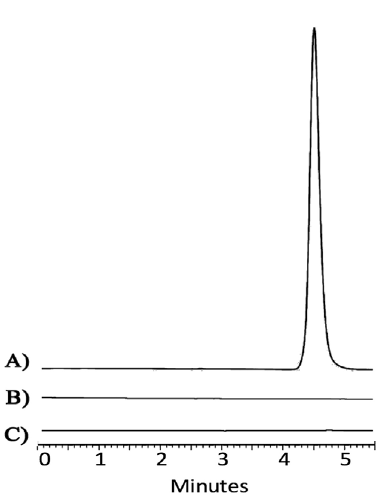
FIGURE 2 - Representative chromatograms of: A) ferulic acid sample solution, B) supernatant from blank PLGA nanoparticles, C) 0.5% chitosan solution.